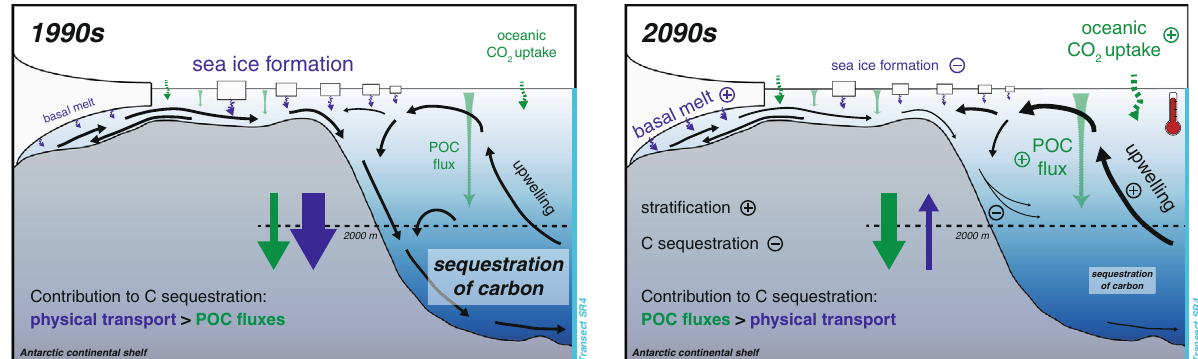
Fig. 8 Sketch illustrating the simulated changes over the 21st century in the high-emission scenario. Compared to the 1990s, deep-ocean carbon sequestration in the southern Weddell Sea is reduced by 60%, which is largely attributed to a reduction in the physical transport of carbon to the abyss. In particular, sea-ice formation is reduced by 16%, and ice-shelf basal melt increases by 79%, which both act to decrease the density of water on the continental shelf. Despite the 10-fold increase in oceanic CO 2 uptake and a 47% increase in sinking fl uxes of biotic particles (POC), the decline in physically-driven downward transport dominates, as newly formed lighter dense waters on the continental shelf are transferred to shallower depths in the 2090s, reducing carbon accumulation in the deep ocean. In the sketch, font sizes and arrow thicknesses in the 2090s are scaled to approximately represent the magnitude of the simulated processes or